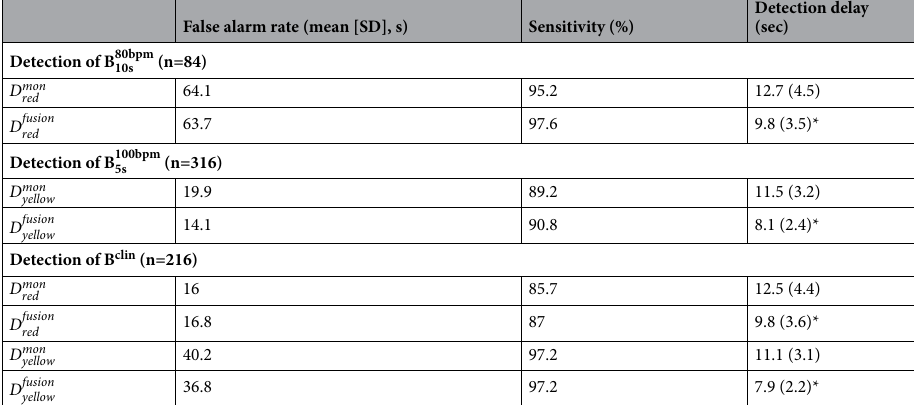
D fusion red , ( p < 0.05 ) between monitor and fusion